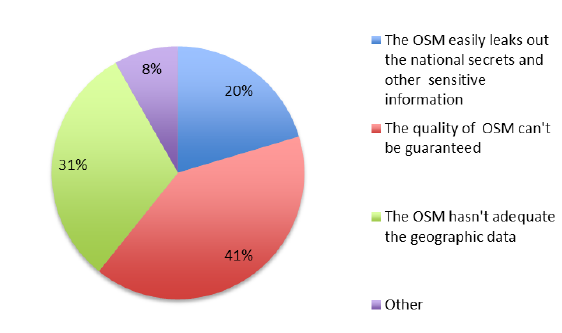
Figure 9. The inadequate of OSM in users’